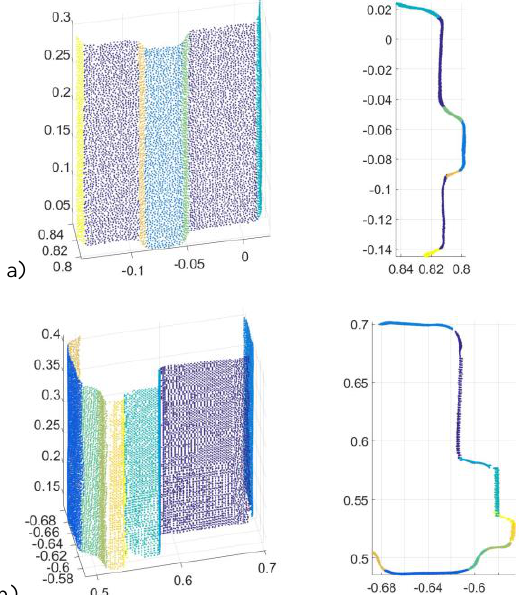
Figure 9. Result of segmentation into planar primitives applied on Kinect point clouds of window (a) and door (b).